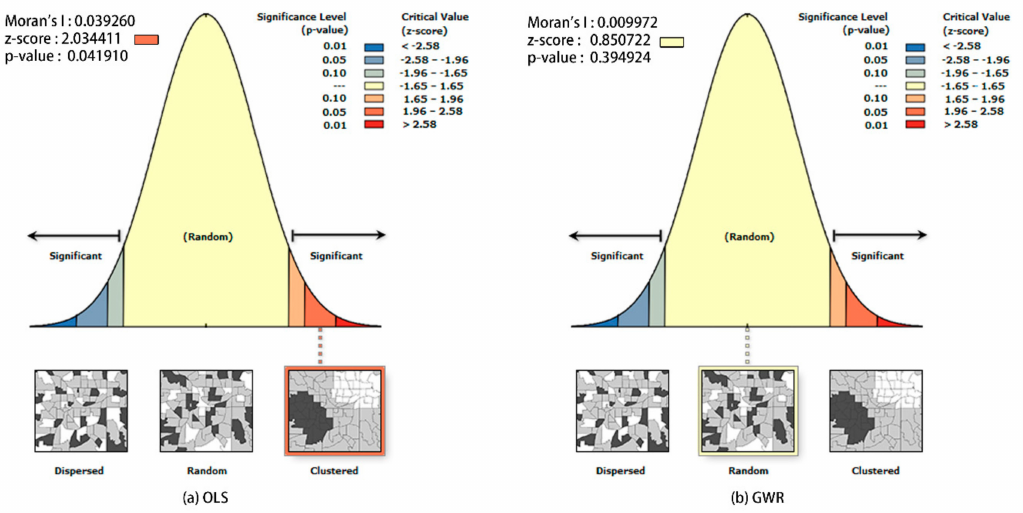
Figure 5. Comparison of Residual Moran’s I index for traditional least squares method (OLS) ( a ) and global weighted regression (GWR) ( b )